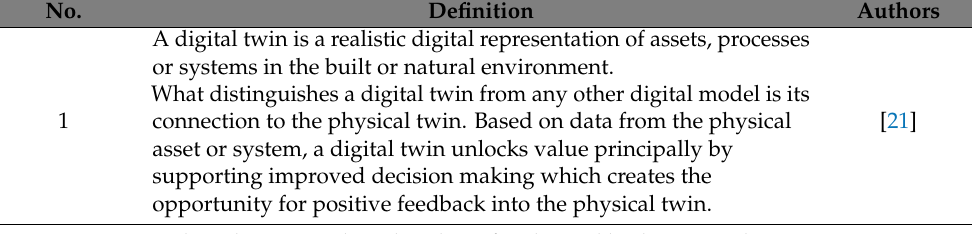
Table 2. Various definitions of the term “digital twin” in literature.